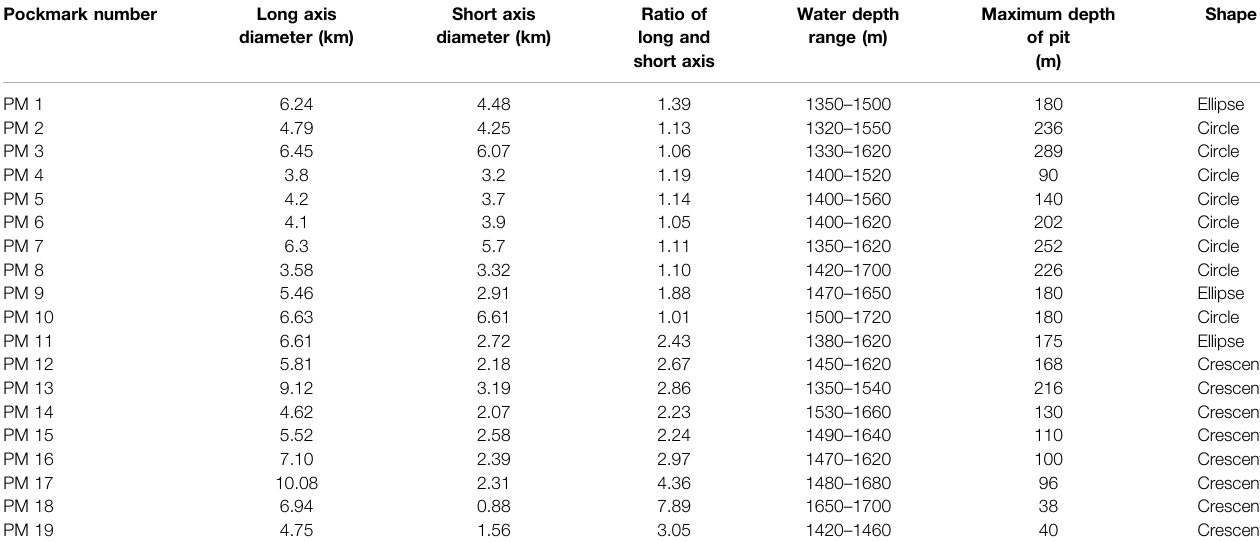
TABLE 1 | Summary of morphometrics of the studied pockmarks. Pockmark number